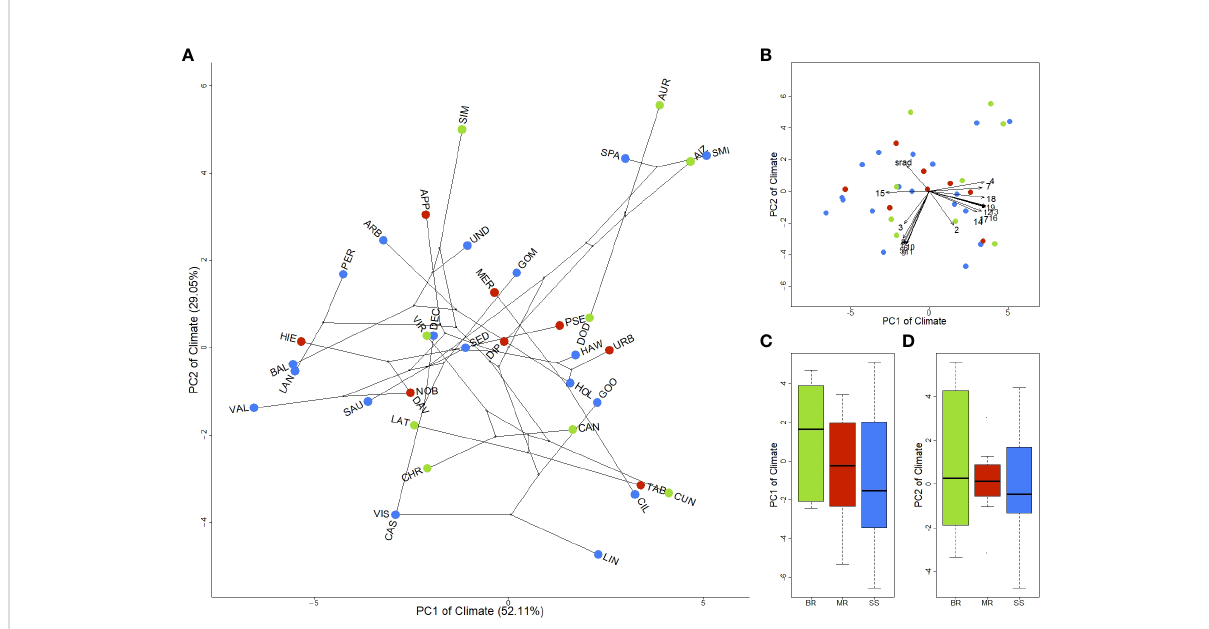
FIGURE 3 Phylogenetic principal component analysis of the climatic space of the Canarian Aeonium . (A) Phylogenetic principal component analysis of the climatic space of Canarian Aeonium . Each dot represents the mean of one taxon (species or subspecies). Lines indicate phylogenetic relationships among species. Taxa are indicated on each dot by a three-letter acronym (see Supplementary Table 1); (B) Loadings of the climatic variables of the phylogenetic principal component analysis. Numbers (1-19) indicate BIOs, and srad indicates the annual potential solar radiation (see Supplementary Table 3); (C) Distribution of growth forms along the fi rst axis of the climatic space (PC1); (D) Distribution of growth forms along the second axis of the climatic space (PC2). Colors represent growth forms: green – BR (branching rosettes), red – MR (monocarpic rosettes), blue – SS (Shrubs or subshrubs). PCA loadings in Supplementary Table